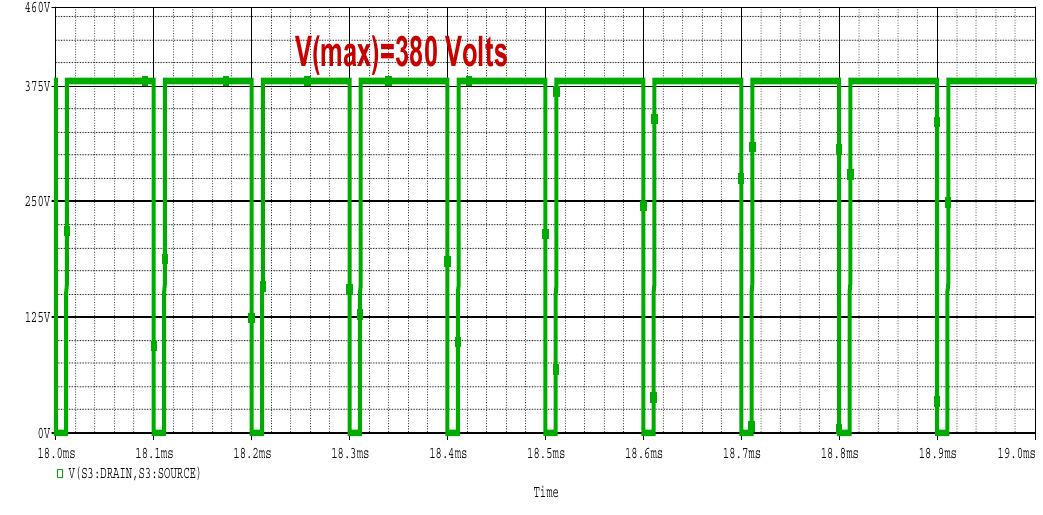
Figure 21. Voltage across battery and current through battery for a 10% duty cycle.